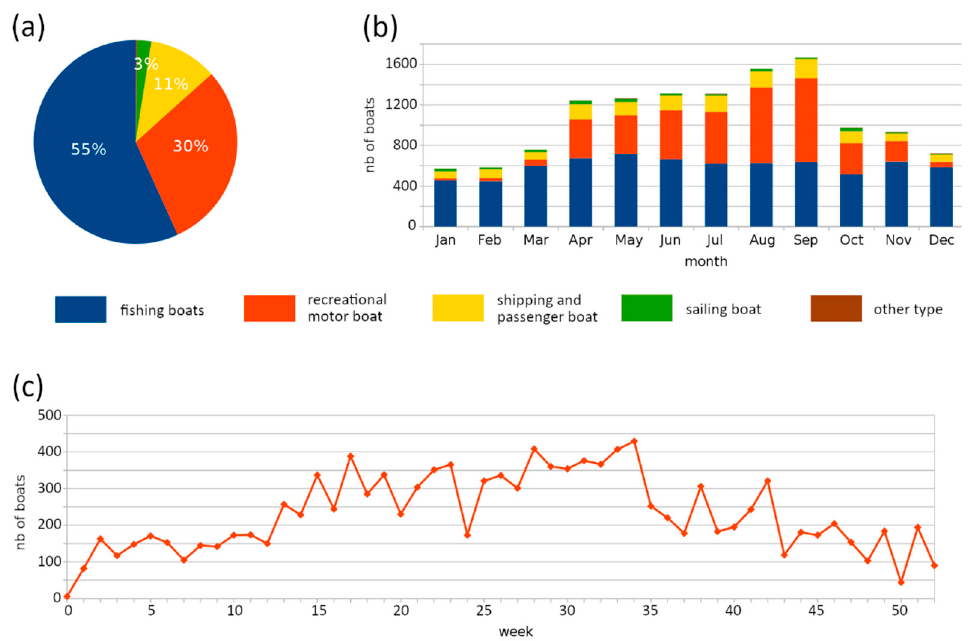
Figure 14. Characterization of the boat traffic recorded by Saint-Mathieu sémaphore for 2011 from the clean input data of t.vect.createRoutes.py. ( a ): type of boats observed in 2011 (% annual traffic); ( b ): monthly traffic by type of maritime activities (2011); ( c ): weekly traffic observed by Saint-Mathieu sémaphore (2011). Legend for ( a ) and ( b ): in blue = fishing boats, in orange = recreational motor boats, in yellow = shipping/passenger boats, in green = sailing boats, in brown = other type.